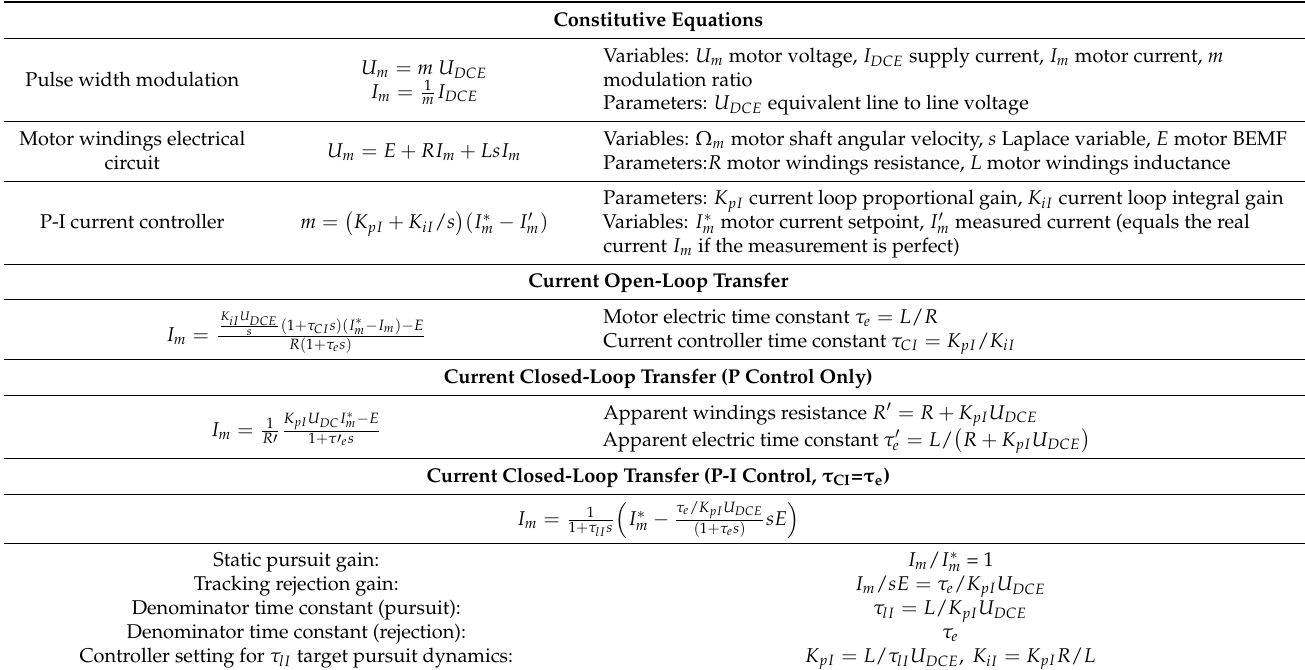
Table A1. Current loop model and analysis in continuous time domain. Constitutive